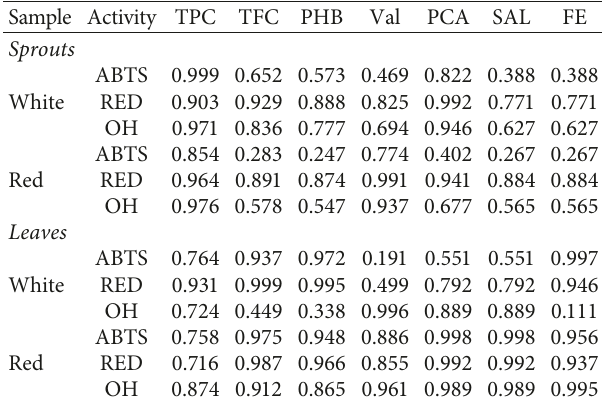
Table 3: Correlation coefficients between phenolic compounds level and antioxidant